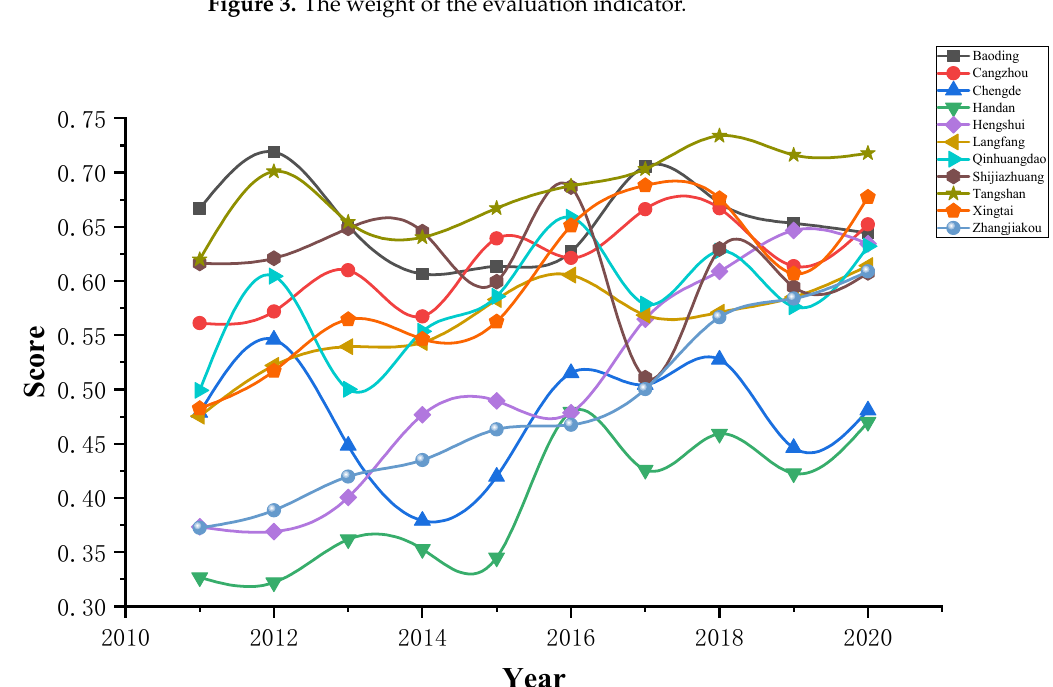
Figure 4. Comprehensive score value of water use.